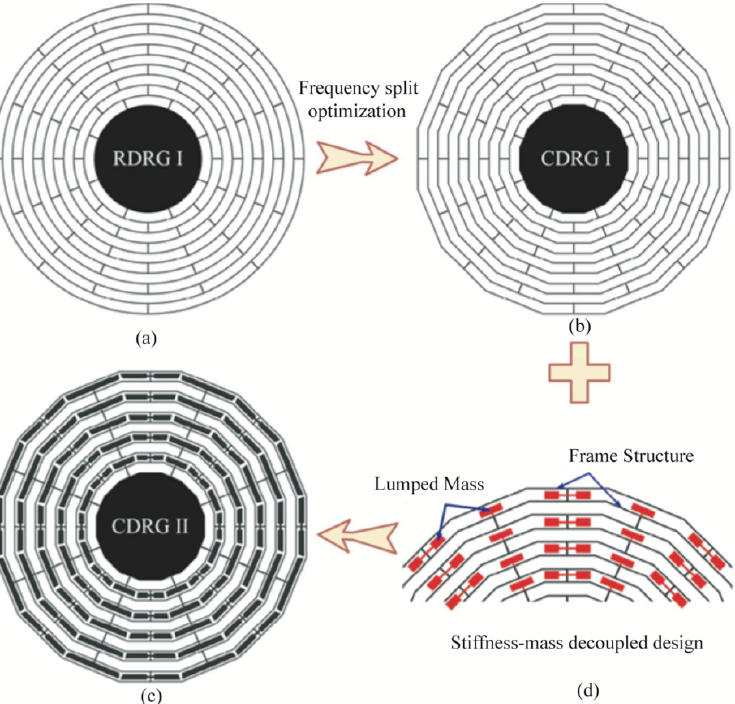
Figure 7. Evolution of a new spider-web type disc resonant gyro designed by Soo chow University; ( a ) disk resonator gyroscope (RDRG I); ( b ) simple cobweb-like disk resonator gyroscope (CDRG I); ( c ) stiffness-mass decoupled design; ( d ) final design of cobweb-like disk resonator gyroscope (CDRG II).